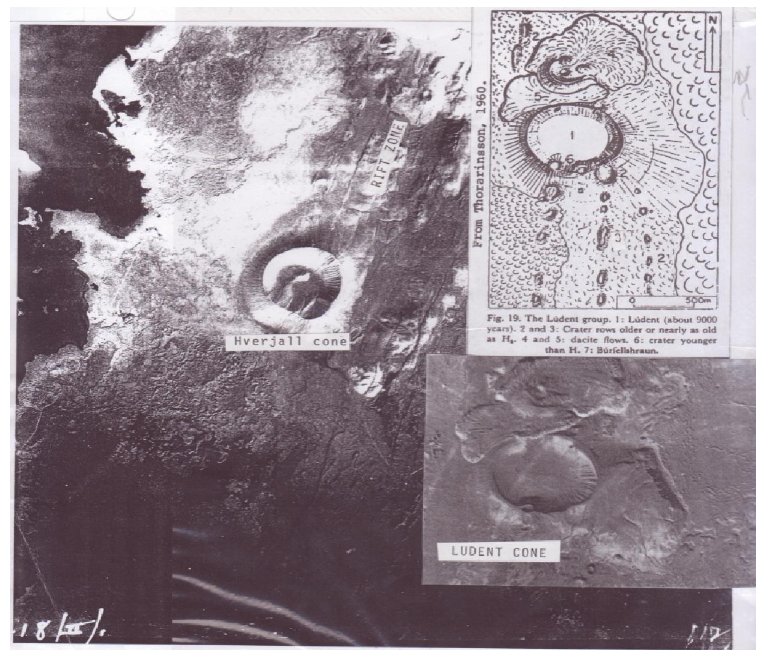
Figure 4. Lùdent and Hverfjall Craters. Area east of Lake Mývatn, north Iceland showing Hverfjall and Lùdent craters and portion of rift region. See text. Image of Lùdent crater courtesy of Landmaelingar